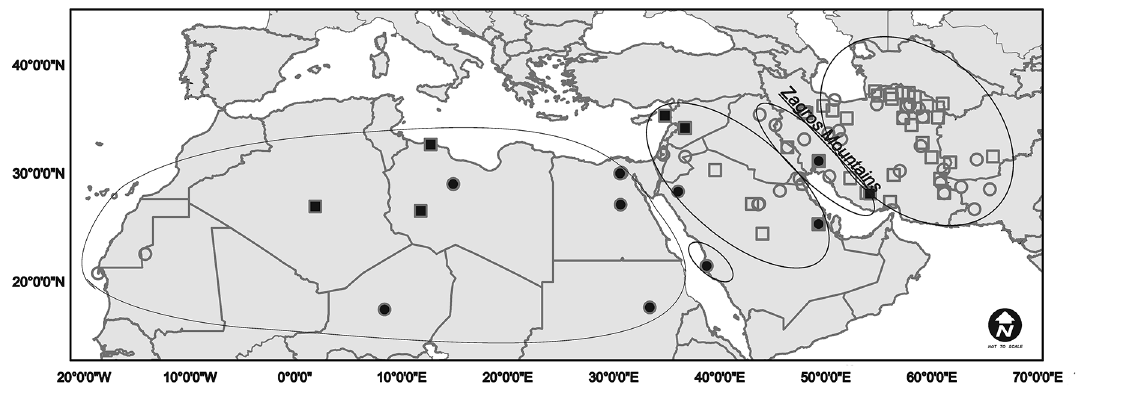
Fig. 1. Map showing the sampling localities of Meriones crassus Sundevall, 1842 (circles) and M. libycus Lichtenstein, 1823 (squares) and groups of sampling localities indicated by ellipses (see more detail about the grouping in Material and Methods). The dark closed symbols are the sampling localities of the type specimens (synonyms of Meriones crassus and M. libycus , see Table 1). The ellipses (from left to right) show the following groups: African, Jeddah, Arabian, Western Zagros and Iranian